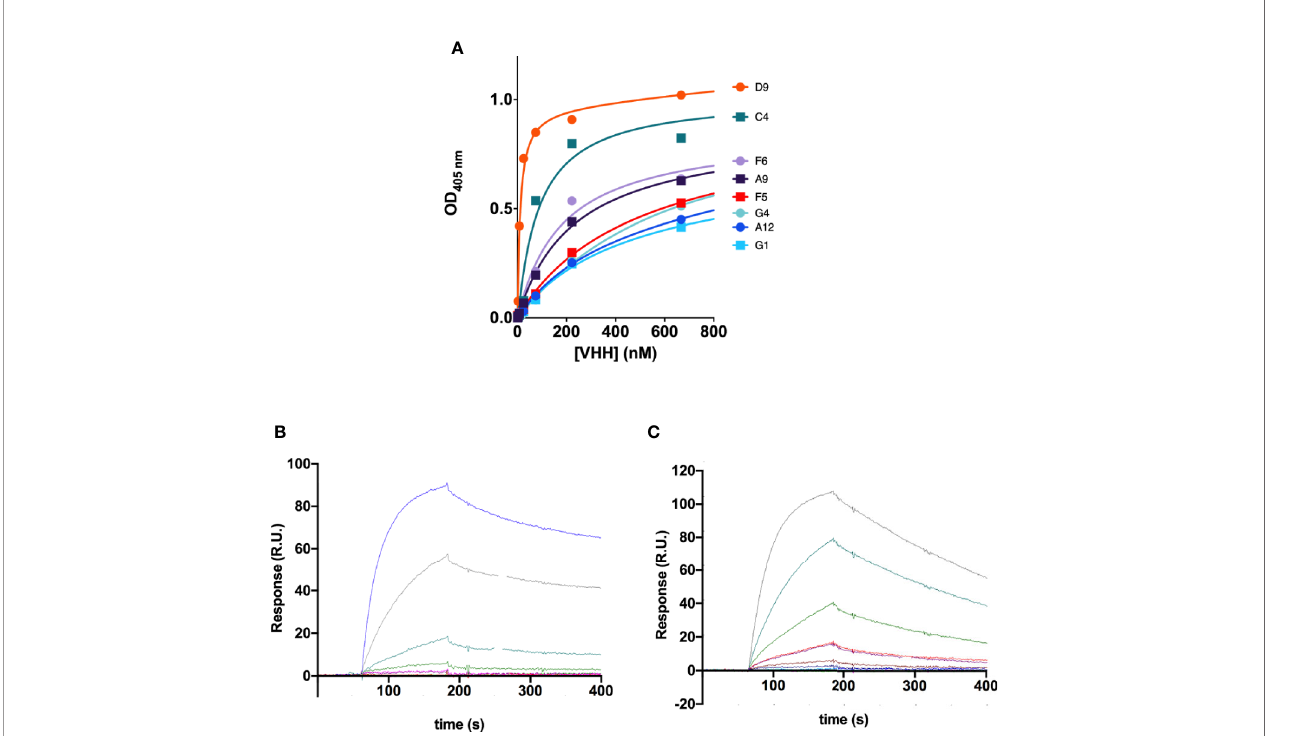
FIGURE 2 | Af fi nity of the anti-Kv10.1 nanobodies. (A) Apparent af fi nities of the VHH antibodies determined by ELISA against the antigen used for immunization. The values resulting from the fi t are listed in Table 1 . D9 and C4 showed the highest af fi nity. (B) Af fi nity and kinetics of binding of VHH C4 on h1x immobilized on a surface plasmon resonance (SPR) sensor chip. The concentration used in each sesorgram is listed in the main text. R.U.: resonance units. (C) SPR sensorgrams for nanobody D9.